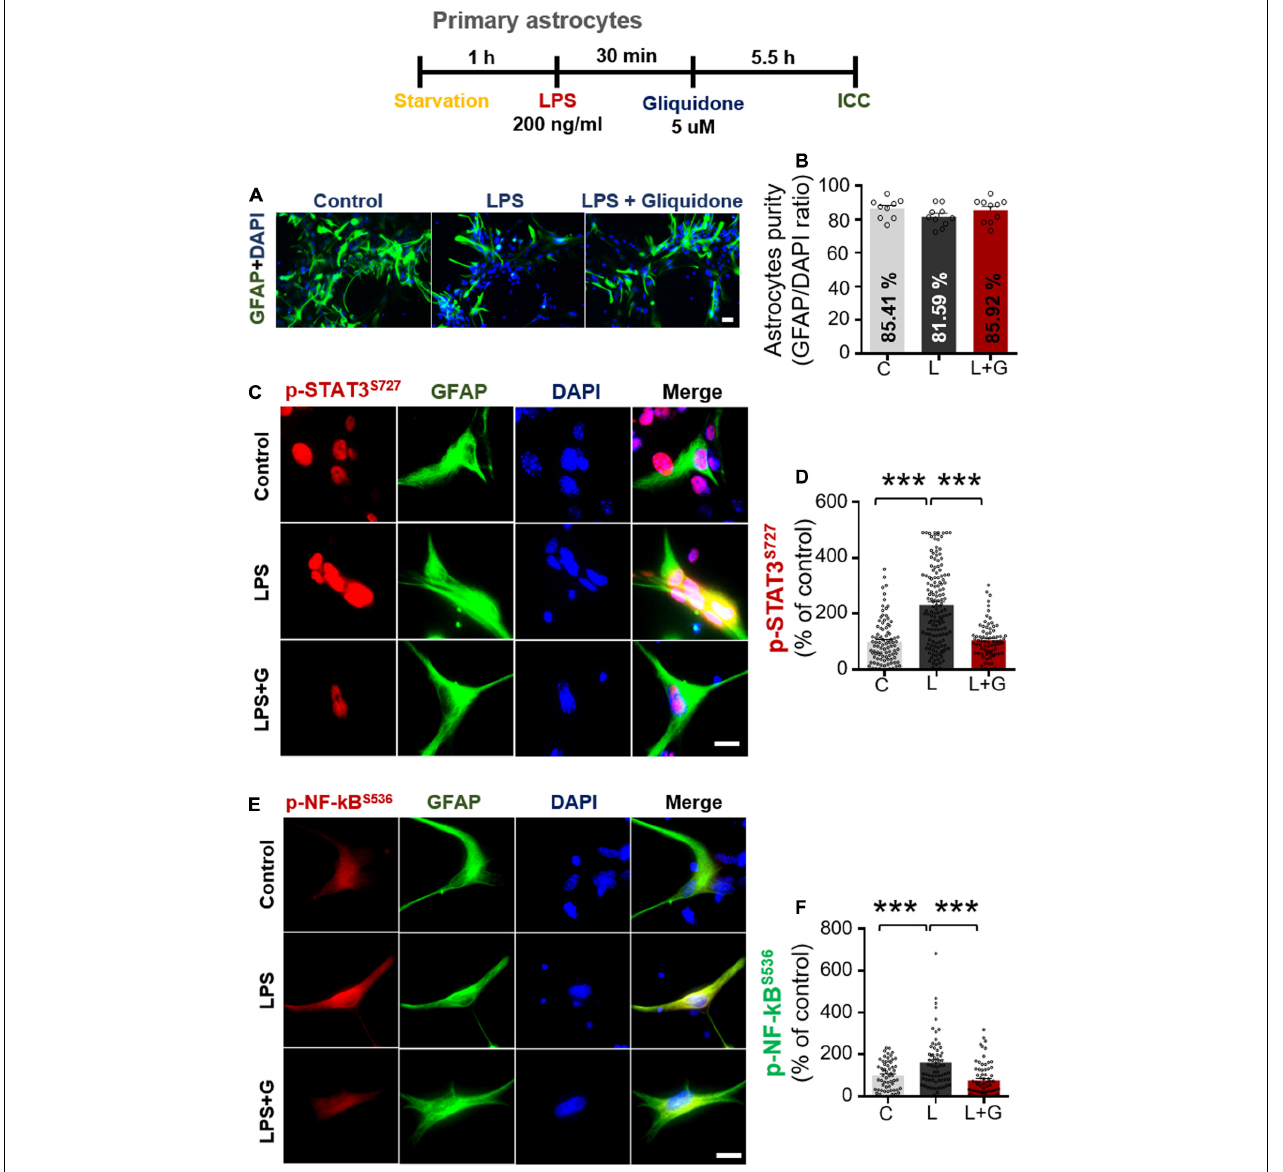
FIGURE 10 | Gliquidone abolishes LPS-induced STAT3 and NF- κ B phosphorylation in primary astrocytes. (A,B) Primary astrocytes were treated sequentially with LPS or PBS and with gliquidone (5 µ M) or vehicle (1% DMSO) as indicated, and immunocytochemistry was performed with an anti-GFAP antibody. The purity of the primary astrocytes was measured by the GFAP/DAPI ratio (C, n = 1726; L, n = 876; LPS + gliquidone, n = 1527). (C–F) Immunocytochemistry analysis of GFAP and p-STAT3 S 727 or GFAP and p-NF- κ B S 536 expression in primary astrocytes treated sequentially with LPS and gliquidone (p-STAT3 S 727 : C, n = 94; L, n = 145; LPS + gliquidone, n = 76; p-NF- κ B S 536 : C, n = 59; L, n = 68; LPS + gliquidone, n = 75). *** p < 0.001, Scale bar = 20 µ